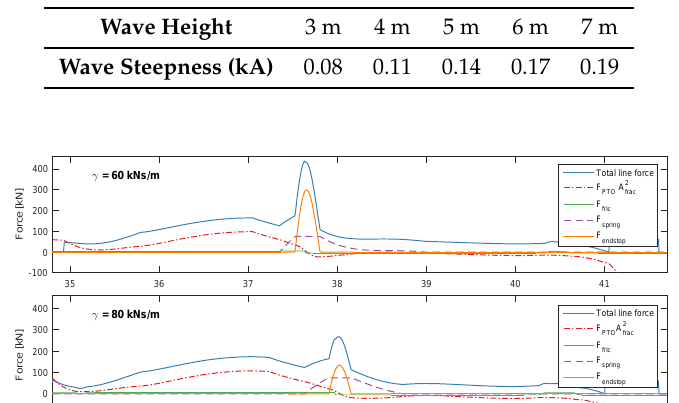
, F fric , F spring , F endstop frac